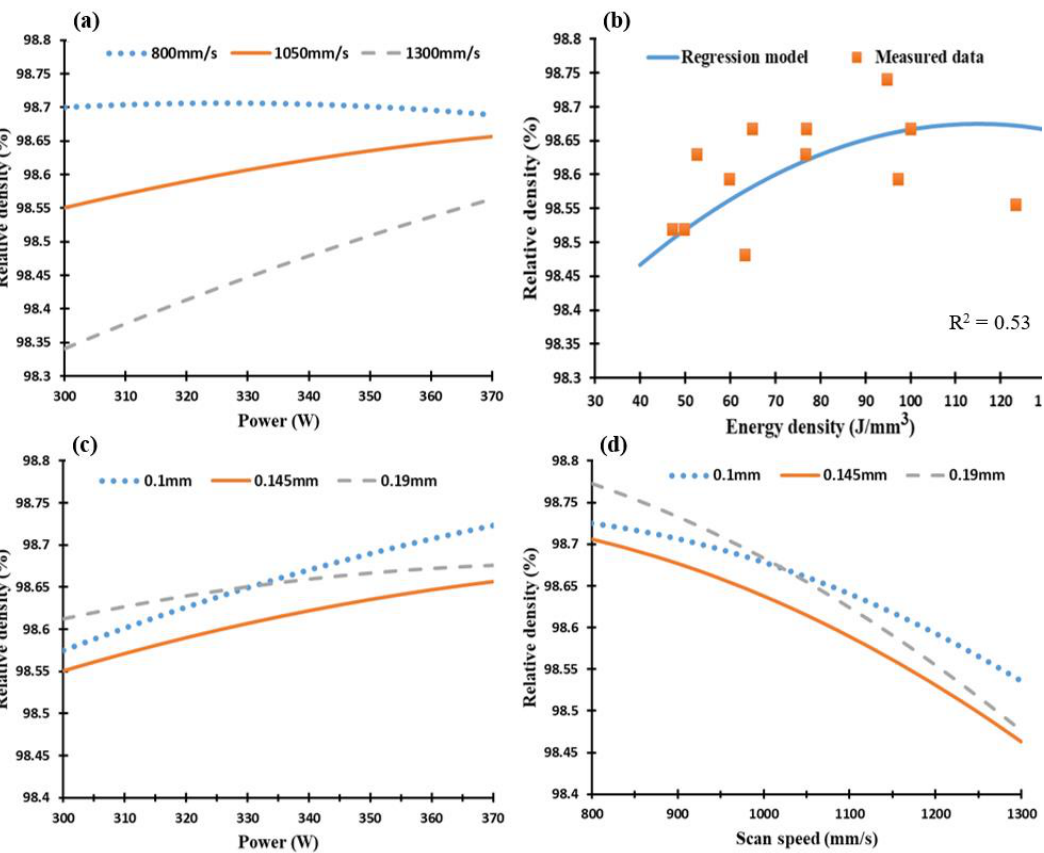
Figure 7. Relative density of the as-built Al6061 samples vs. ( a ) laser power (W), ( b ) energy density (J/mm 3 ), ( c ) hatch spacing (mm), and ( d ) scan speed